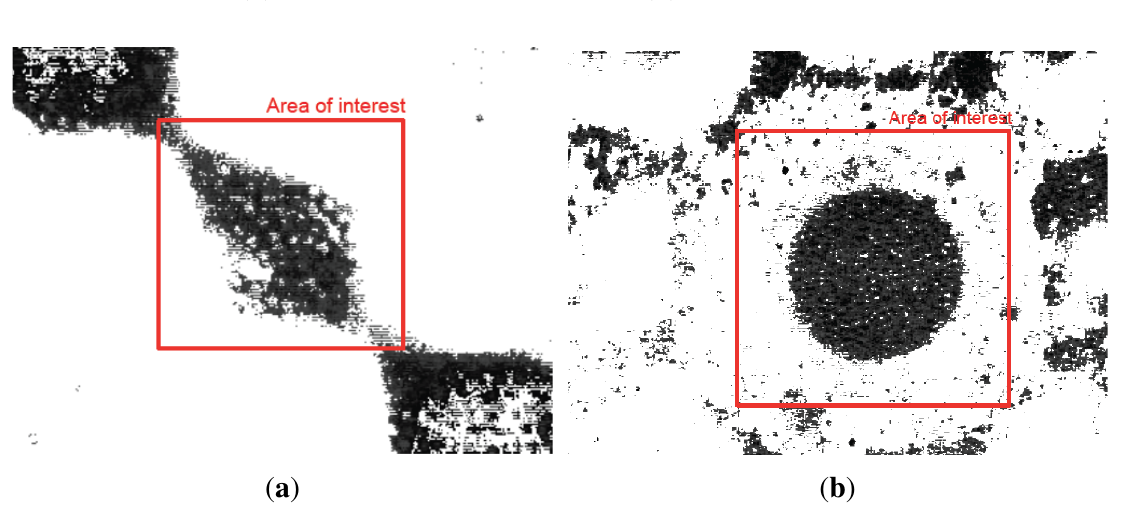
Figure 17. Image processing with MATLAB of captured image from Suss microscope using 0.97 µ m diameter polystyrene microspheres (dyed red) from Bangs Laboratories exposed to DEP forces within ( a ) a 4-electrode architecture and ( b ) an 8-electrode